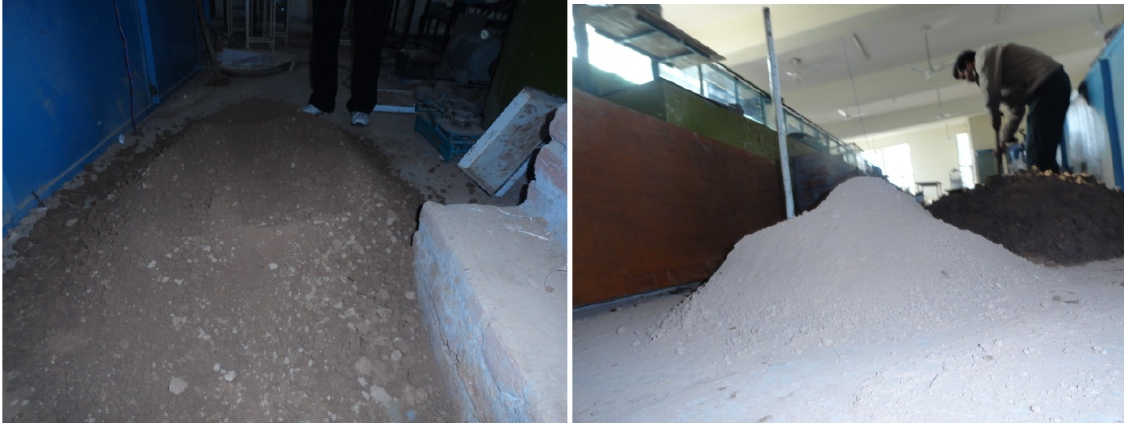
Figure 3. Material procurement and treatment.